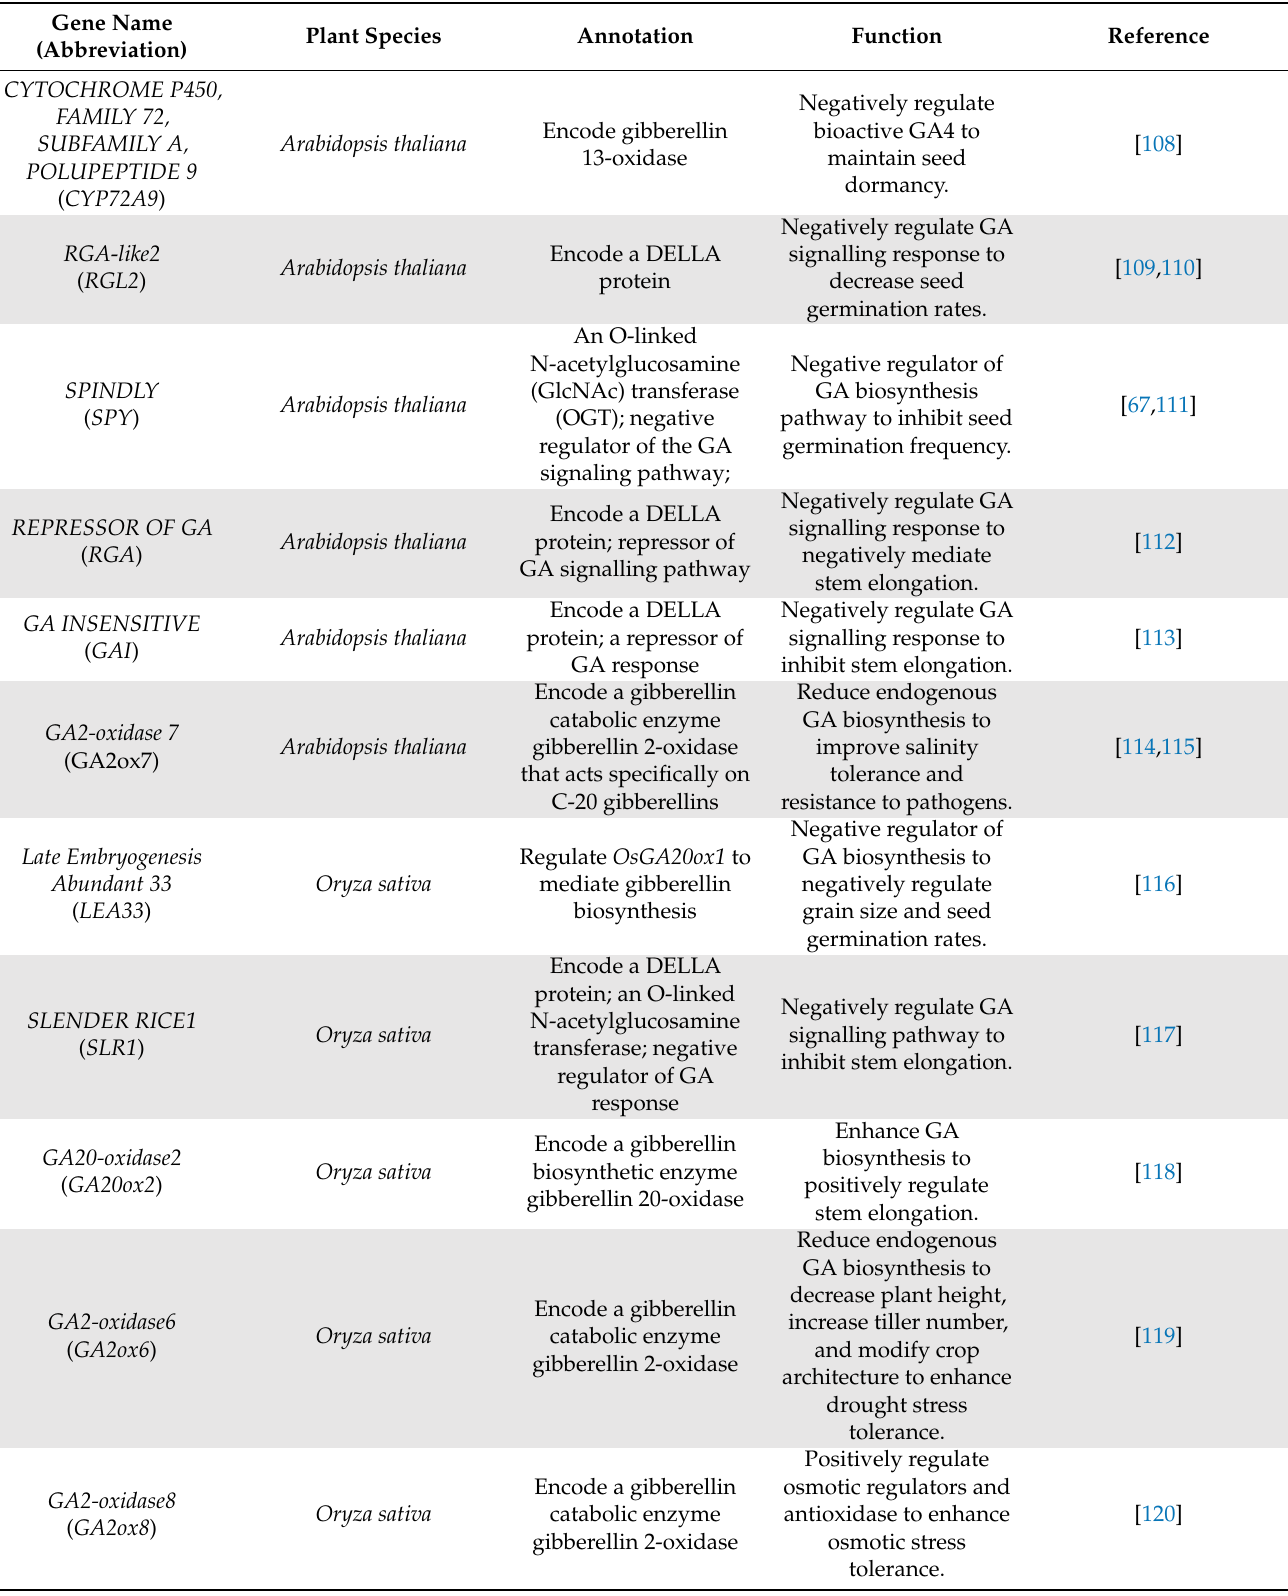
Table 1. Genes involved in GA metabolism and signalling for regulating plant